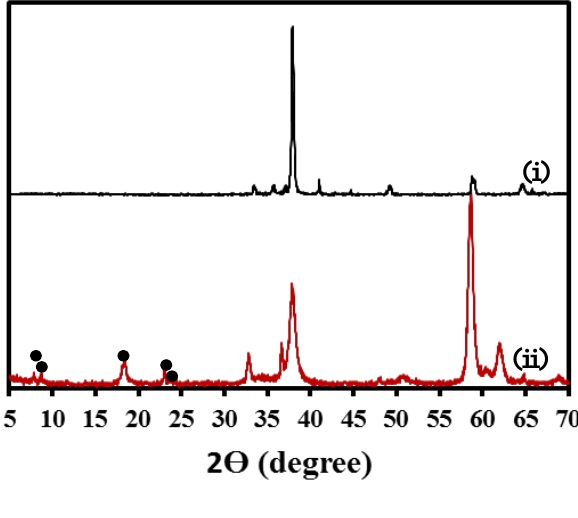
Figure 2. XRD spectra of (i) uncoated and (ii) zeolite coated